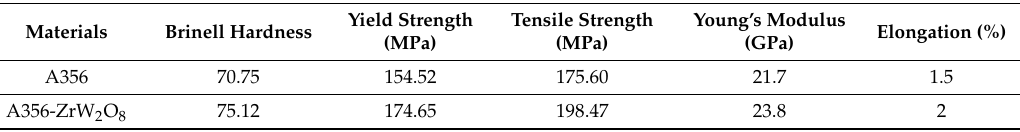
Table 3. Mechanical properties of the A356 and A356 / ZrW 2 O